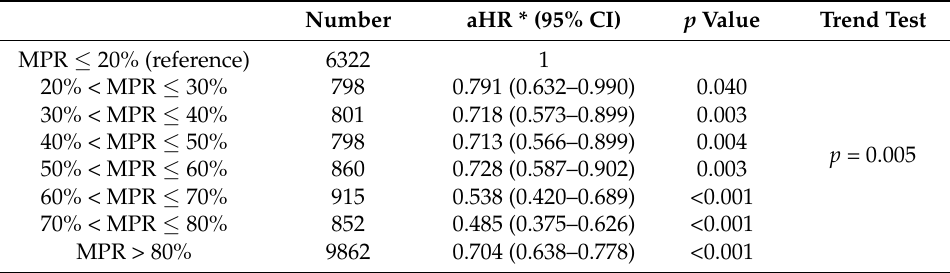
Table 4. Dose frequency effect of ARB usage on dementia.